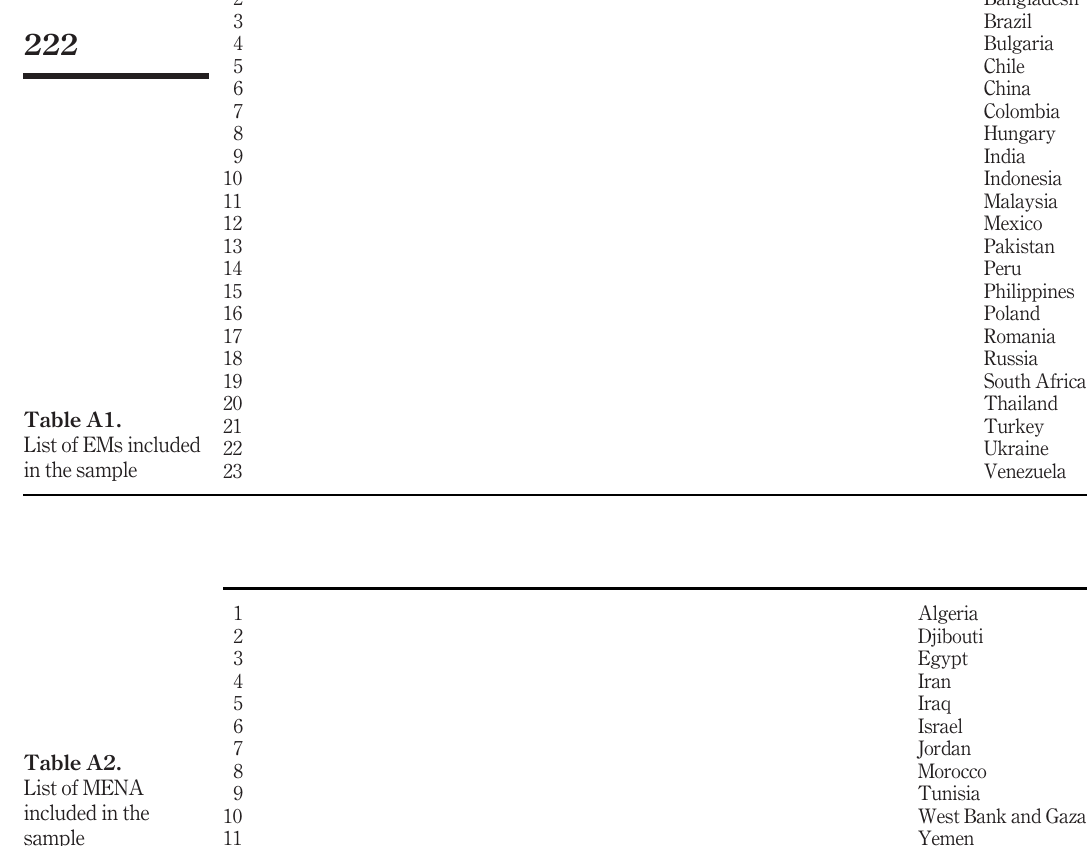
Table A2. List of MENA included in the